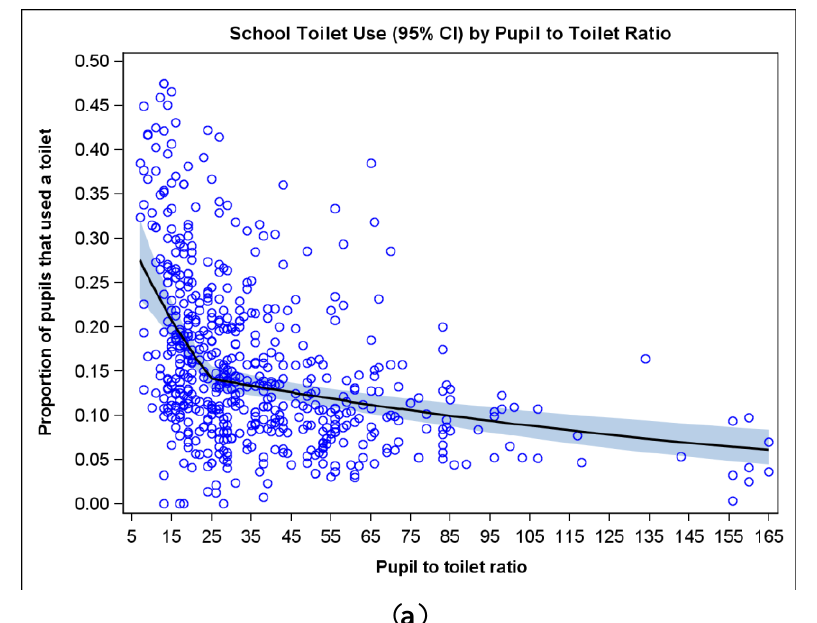
Figure 1. ( a ) Proportion of pupils who used a toilet at each school as a function of pupil to toilet ratio. ( b ) Average uses per toilet at each school as a function of pupil to toilet